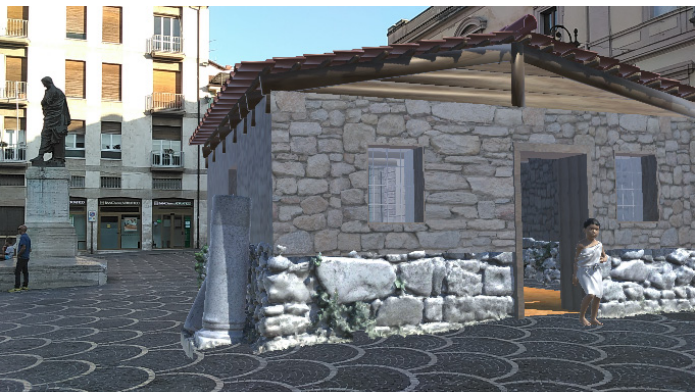
Figure 9. Mobile AR application for improving the experience of the tourists. Courtesy of Boboc et al. [6]. et al.